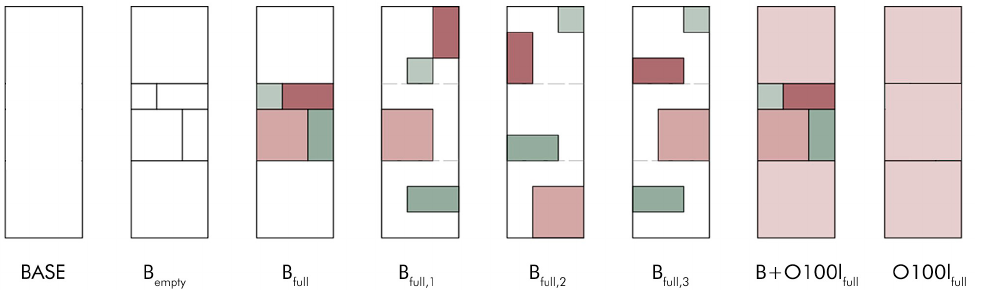
Figure 5. Design configurations of Pattern-B and the basic module of the total area. The Pattern-B is subdivided as follows: the smaller sub-module (light green) is a 100x100 mm square; the two rectangular sub-modules (green and red) have the dimensions of 100x200 mm; finally, the bigger sub-module is a 200x200 mm square.